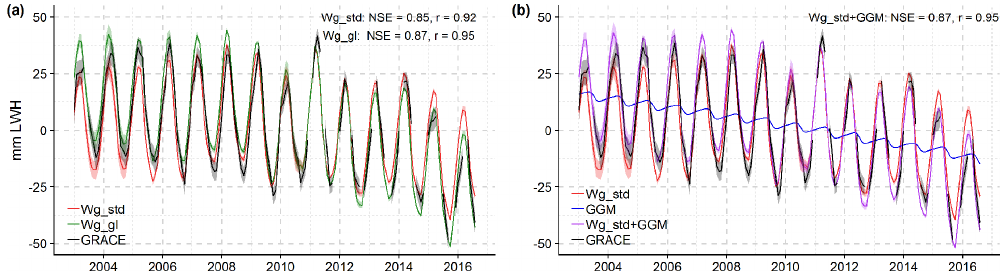
Figure 3. Global mean monthly TWSA from GRACE observations and from different modelling approaches from January 2003 to August 2016. (a) TWSA from GRACE ensemble, LWSA from standard WaterGAP (Wg_std) in anthropogenic mode en- semble (Wg_std_ant_CRU_irr100, Wg_std_ant_CRU_irr70, Wg_std_ant_GPCC_irr100 and Wg_std_ant_GPCC_irr70 in Table 1) and TWSA from integrated WaterGAP (Wg_gl) in anthropogenic mode ensemble (Wg_gl_ ant_ CRU_ irr100, Wg_gl_ant_CRU_irr70, Wg_gl_ant_GPCC_irr100 and Wg_ gl_ant_GPCC_irr70 in Table 1). (b) TWSA from GRACE ensemble, LWSA from Wg_std ensemble as in (a) , LGWSA from GGM and TWSA obtained by adding anomalies from Wg_std ensemble and GGM (Wg_std + GGM). For each ensemble, the curve represents the ensemble mean, and the shaded area around the curve represents either the uncertainty range (GRACE) or the ensemble range (Wg_std, Wg_gl and Wg_std + GGM). Nash–Sutcliffe efficiency (NSE) and correlation coefficient ( r ) obtained by comparing GRACE and model ensemble means are provided. Anomalies are relative to the mean over January 2006 to December 2015. Millimetres of land water height (mmLWH) are relative to the global continental area without the ice sheets (132 . 3 × 10 6 km 2 ) . Table 3. Linear trends of TWSAs from GRACE observations and from WaterGAP2.2d from January 2003 to August 2016. Model estimates correspond to individual solutions of standard WaterGAP (Wg_std) and integrated WaterGAP (Wg_gl) ensembles. GRACE-derived estimates correspond to SH solutions from four processing centres (Center for Space Research – CSR; German Research Centre for Geosciences – GFZ; Institute of Satellite Geodesy – ITSG; and Jet Propulsion Laboratory – JPL). Trends were calculated according to the linear least squares regression method. Negative trends (mass loss) over the continents, expressed in millimetres of land water height (mmLWH, relative to the global continental area without the ice sheets 132 . 3 × 10 6 km 2 ) , translate to positive trends (mass gain) over the oceans, expressed in